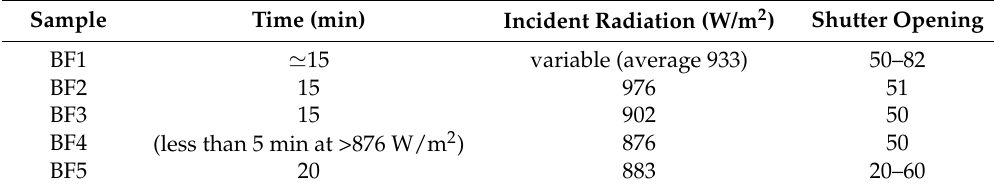
Table 13. Experimental